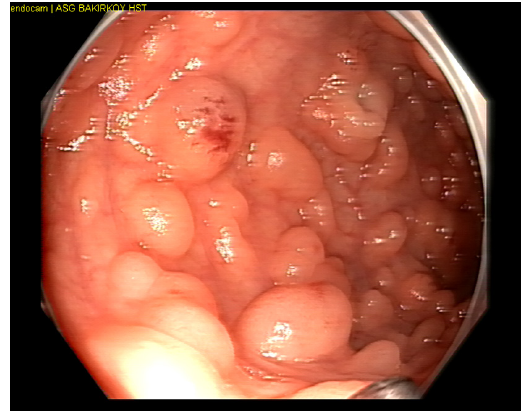
Figure 1. Polypoid lesions in the